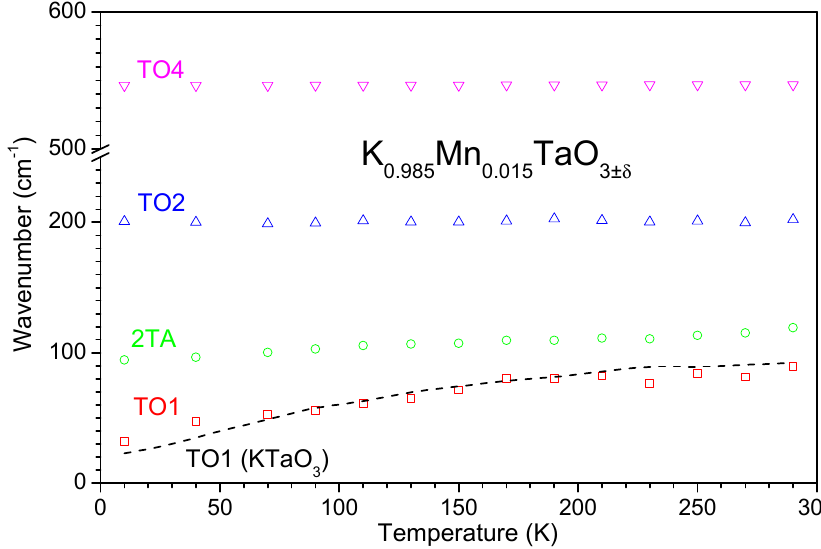
Figure 5. Variation of the TO1 (squares), 2TA (circles), TO2 (up triangles), and TO4 (down triangles) Raman modes in the K 0.985 Mn 0.015 TaO 3± δ ceramics with temperature. The behaviour of the TO1 mode for undoped KT ceramics (dashed line) is shown for comparison.